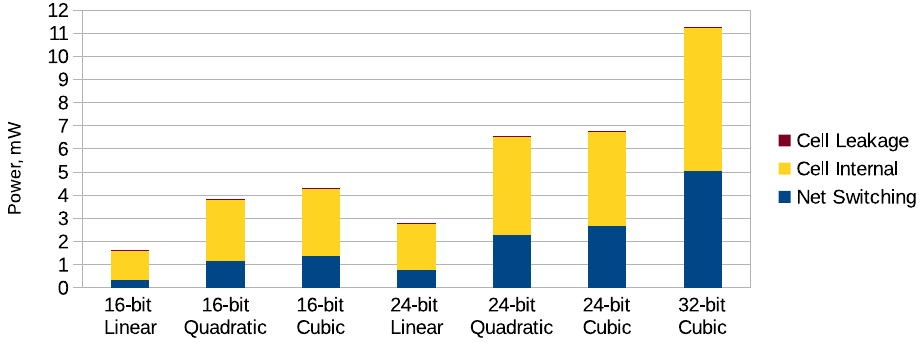
Figure 5. Post-layout results for dynamic and leakage power, f ( x ) = 1/ x .